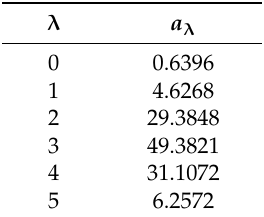
Table 1. Values of the coefficients a λ in Equation (13).